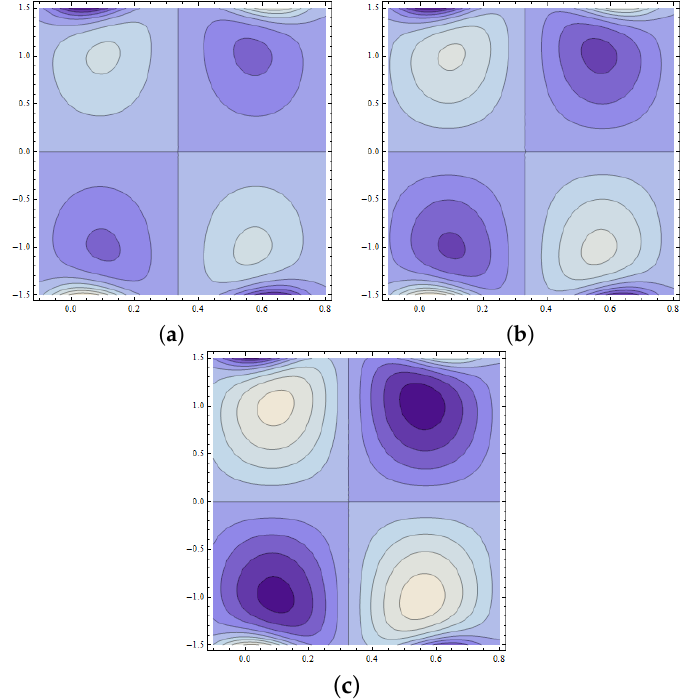
Figure 19. Pattern of streamlines when (cid:101) = 0.1, t = 0.1, m = 0.04, m 1 = 2, E 1 = 0.1, E 3 = 0.3, n = 0.4 and We = 0.4 with ( a ) E 2 = 0.4, ( b ) E 2 = 0.3, ( c ) E 2 =